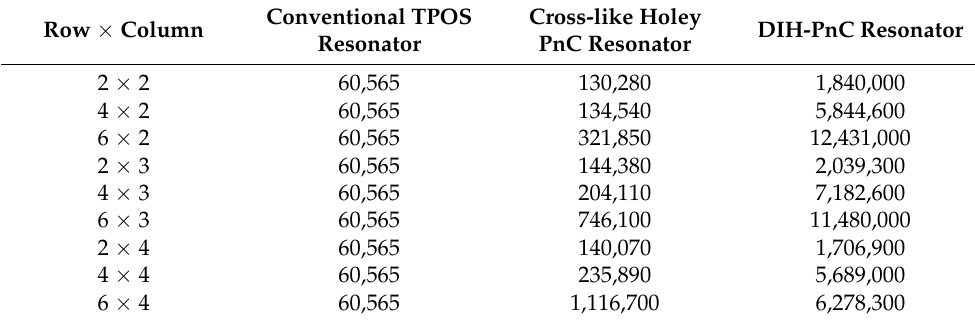
Figure 11. Q anc values under different rows × columns. The x -axis represents different PnC rows × columns layouts, the y -axis represents the different resonator, and the z -axis represents the Q anc values. Red cylinders represent conventional resonators, blue cylinders represent cross-like holey PnC resonators, and yellow cylinders represent DIH-PnC resonators.